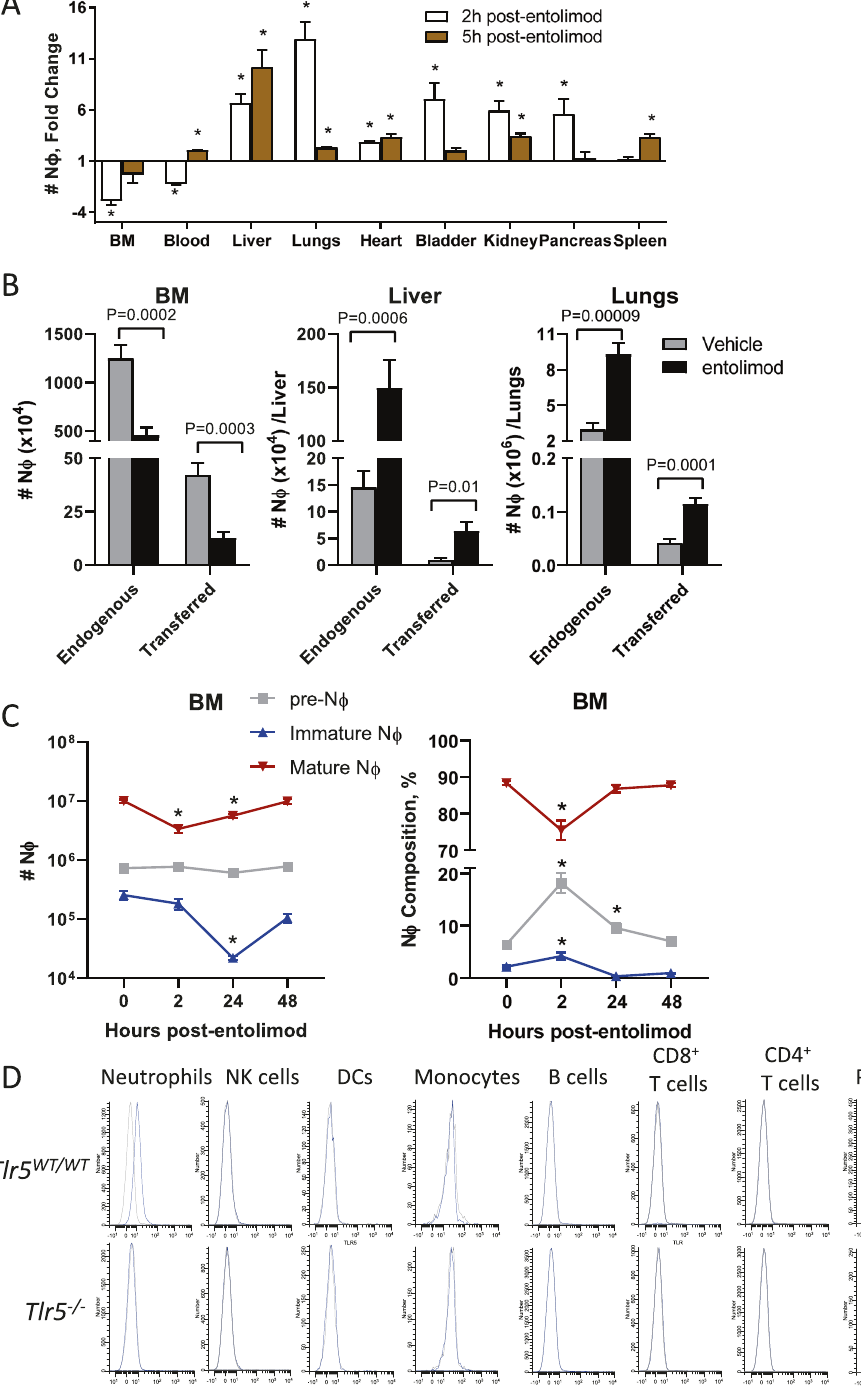
Fig. 2 Entolimod stimulates N ϕ recruitment to tissues and differentiation. A Fold change in the N ϕ response in the indicated organs calculated from the absolute number of N ϕ in entolimod-treated (2 h and 5 h) versus vehicle-treated mice ( n = 3 – 5 mice /group). Flow cytometry was used to identify N ϕ (CD45 + CD11b + Ly-6C + Ly-6G hi ). B Absolute number of endogenous and adoptively transferred N ϕ in the BM, liver, and lungs 2 h post-treatment with vehicle or entolimod ( n = 6 – 8 mice/group). Adoptive transfers were done by i.v. injection of GFP- expressing BM immediately before treatment. Endogenous versus transferred N ϕ were distinguished by fl ow cytometry for GFP among the total N ϕ population (CD45 + CD11b + Ly-6C + Ly-6G hi ). C Absolute number (left) and composition (right) of N ϕ populations in the bone marrow at the indicated time points post-treatment by fl ow cytometry as de fi ned by: pre-N ϕ (Lineage − c-kit int CD115 − CD11b + Gr-1 + CXCR4 + ), immature N ϕ (Lineage − c-kit int CD115 − CD11b + Gr-1 + CXCR4 − CXCR2 − Ly-6G + ), and mature N ϕ (Lineage − c-kit int CD115 − CD11b + Gr-1 + CXCR4 − CXCR2 + Ly-6G + ) where lineage was de fi ned as CD3 − and B220 − ( n = 3 – 9 mice/group). D Flow cytometry-based staining for TLR5 using biotinylated-entolimod plus streptavidin fl uorochrome “ sandwich ” platform on N ϕ (CD45 + CD11b + Ly-6C + Ly-6G hi ), NK cells (CD45 + CD3 ε − NKp46 + ), DCs (CD45 + Ly-6G − B220 − F4/80 − CD11c + ), monocytes (CD45 + Ly-6G − B220 − CD11c − F4/80 + ), B cells (CD45 + Ly-6G − CD11c − F4/80 − B220 + ), CD8 + T cells (CD45 + CD3 ε + CD8 + ), CD4 + T cells (CD45 + CD3 ε + CD4 + ), platelets (CD45 − CD41 + ), and RBCs (CD45 − Ter119 + ) in the blood of BALB/c and Tlr5 − / − mice. Error bars represent mean ± SEM. * P < 0.04; P -values were determined by Student ’ s t